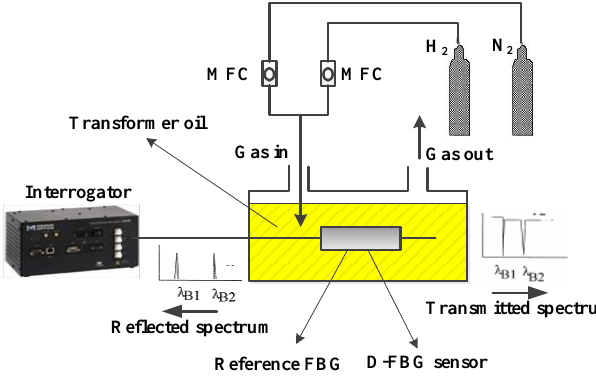
Figure 5. Experimental setup of dissolved hydrogen sensing in oil.